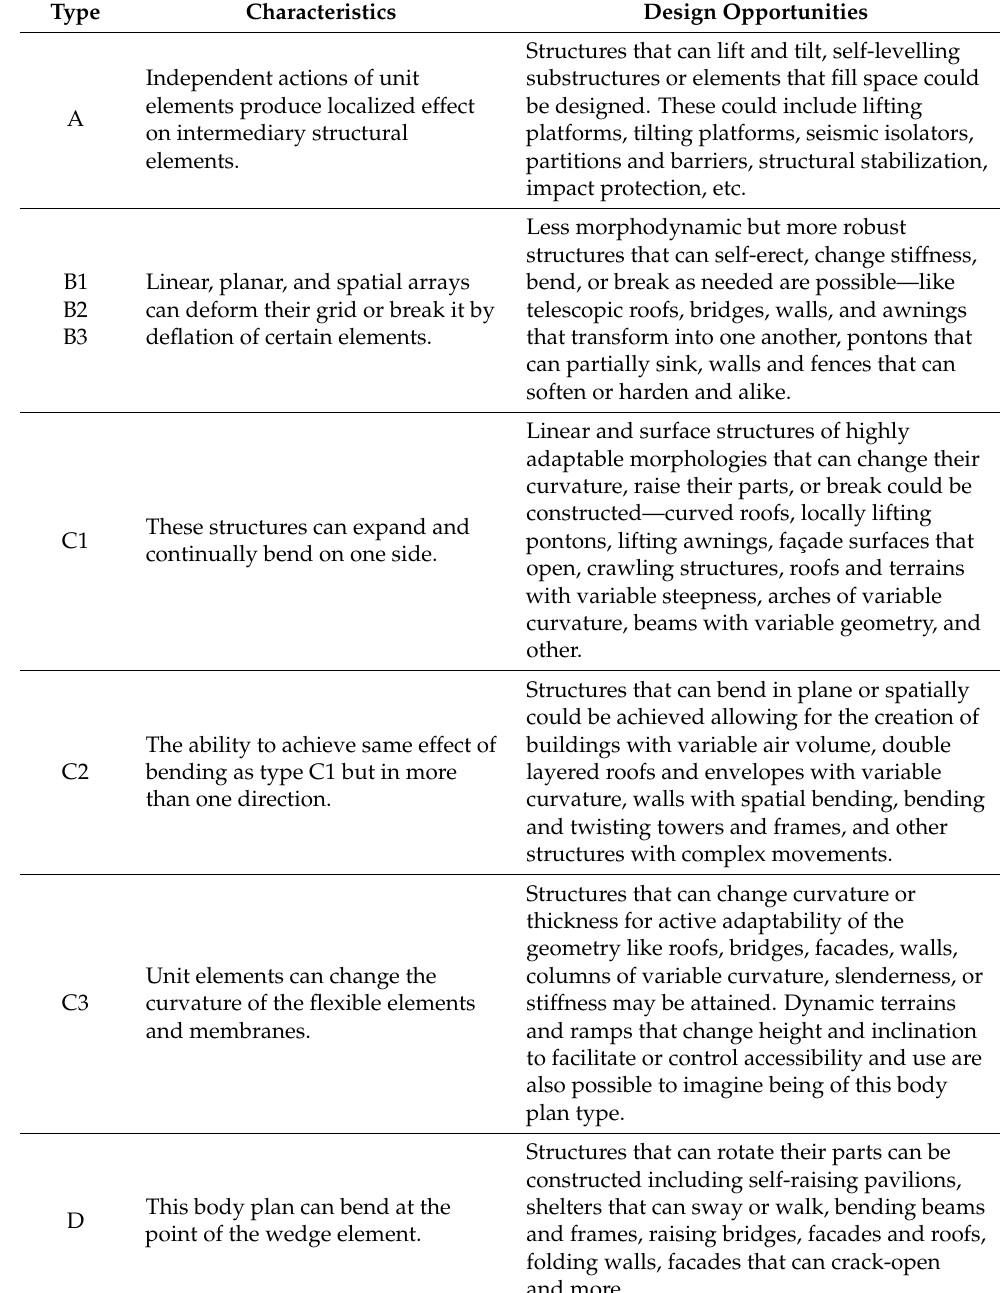
Table 3. Characteristics of analyzed basic body plan types and design opportunities. Note: examples of some practical applications attributed to certain body plan types in this table should not be regarded as limited to that specific body plan type, because they might potentially fit other body plan types as